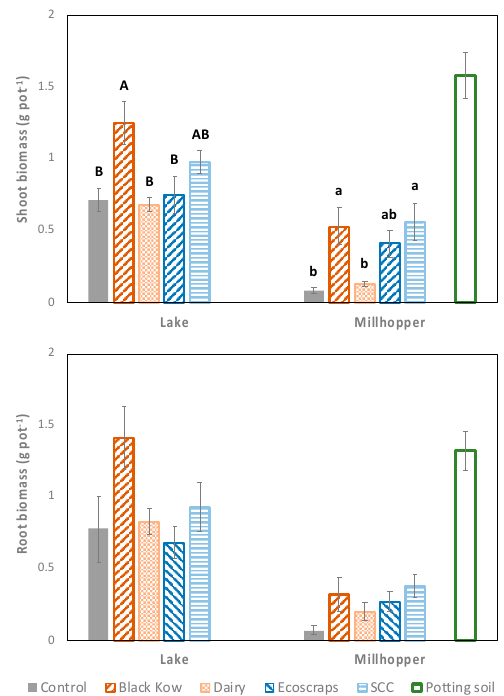
Figure 3. Mean ( ± standard errors) of shoot ( top ) and root ( bottom ) biomass in the Lake, Millhopper, and potting soils. Different letters represent statistically different means among amendments based on Tukey’s HSD ( α ≤ 0.05); there were no significant differences among amendments for root biomass ( p > 0.17 for all analyses). The potting soil was not included in the analysis. Plant nutrients were measured for all treatments in the Lake soil, but only for Black Kow, SCC, and Ecoscraps in the Millhopper soil; we only report data for the Lake soil in Figure 4 given the lack of data for the control in the Millhopper soil. There were differ- ences among treatments in the Lake soil for all variables measured (Figure 4), except for N concentration ( p = 0.23). Tissue K concentration ( p < 0.001) and accumulation ( p < 0.001) were greater in the SCC (6.4% K, 63 mg K pot − 1 ), Ecoscraps (5.4% K, 41 mg K pot − 1 ), and Black Kow (5.3% K, 64 mg K pot − 1 ) treatments compared to the control (3.4% K, 24 mg K pot − 1 ). Tissue P concentration ( p = 0.04) and accumulation ( p = 0.01) were higher with SCC (1.3% P, 14 mg P pot − 1 ) relative to the control (0.7% P, 5 mg P pot − 1 ), and P accumulation was also greater with Black Kow (14 mg P pot − 1 ) relative to the control. Tissue N accumu- lation ( p < 0.001) was greater with Black Kow (23 mg N pot − 1 ) compared to the control (15 mg N pot − 1 ).